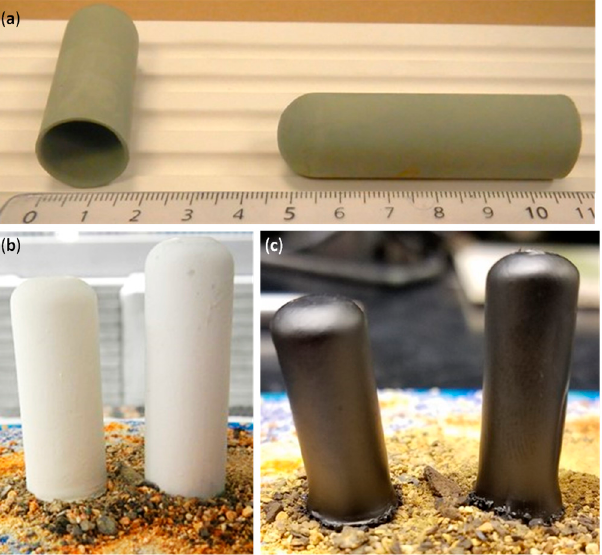
Figure 2. BCZY27-NiO slip cast tubes: ( a ) after casting, ( b ) after dip-coated the BCZY27 electrolyte, and ( c ) after co-sintering.